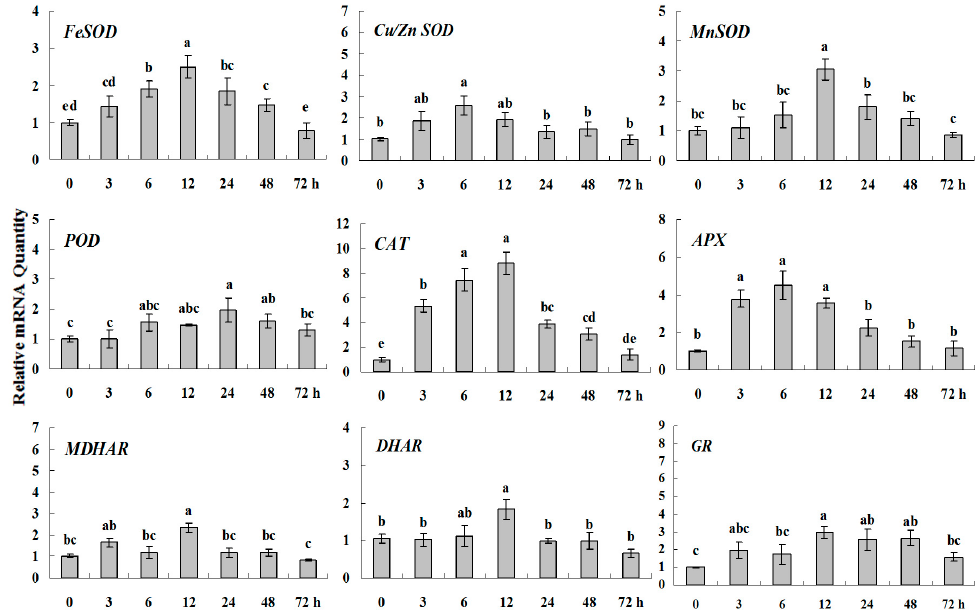
Figure 4 . Quantitative real-time RT-PCR was used to analyze of ROS-scavenging enzyme genes expression during drought stress and normalized to β -actin . White clover leaves were sampled after 0, 3, 6, 12, 24, 48 and 72 h treatment. Data represent means of three replicates. Error bars representing standard errors and the different letters above the bars represent significant difference ( p < 0.05).